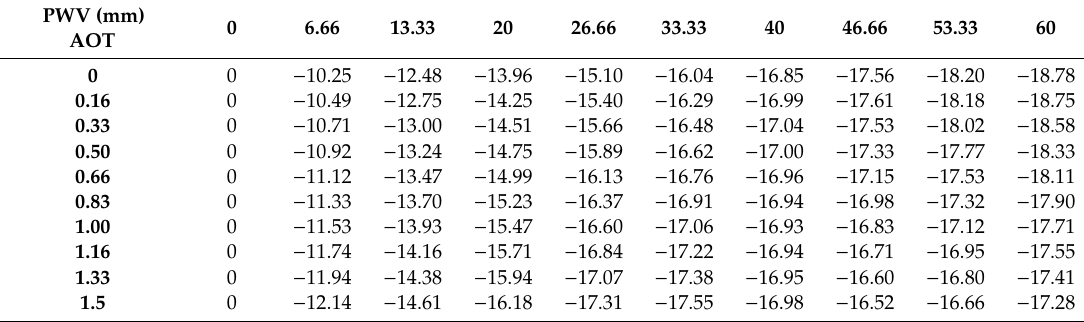
Table 2. Relative di ff erence values (%) describing the PWV e ff ect on shortwave irradiance for each combination of AOT and PWV values.